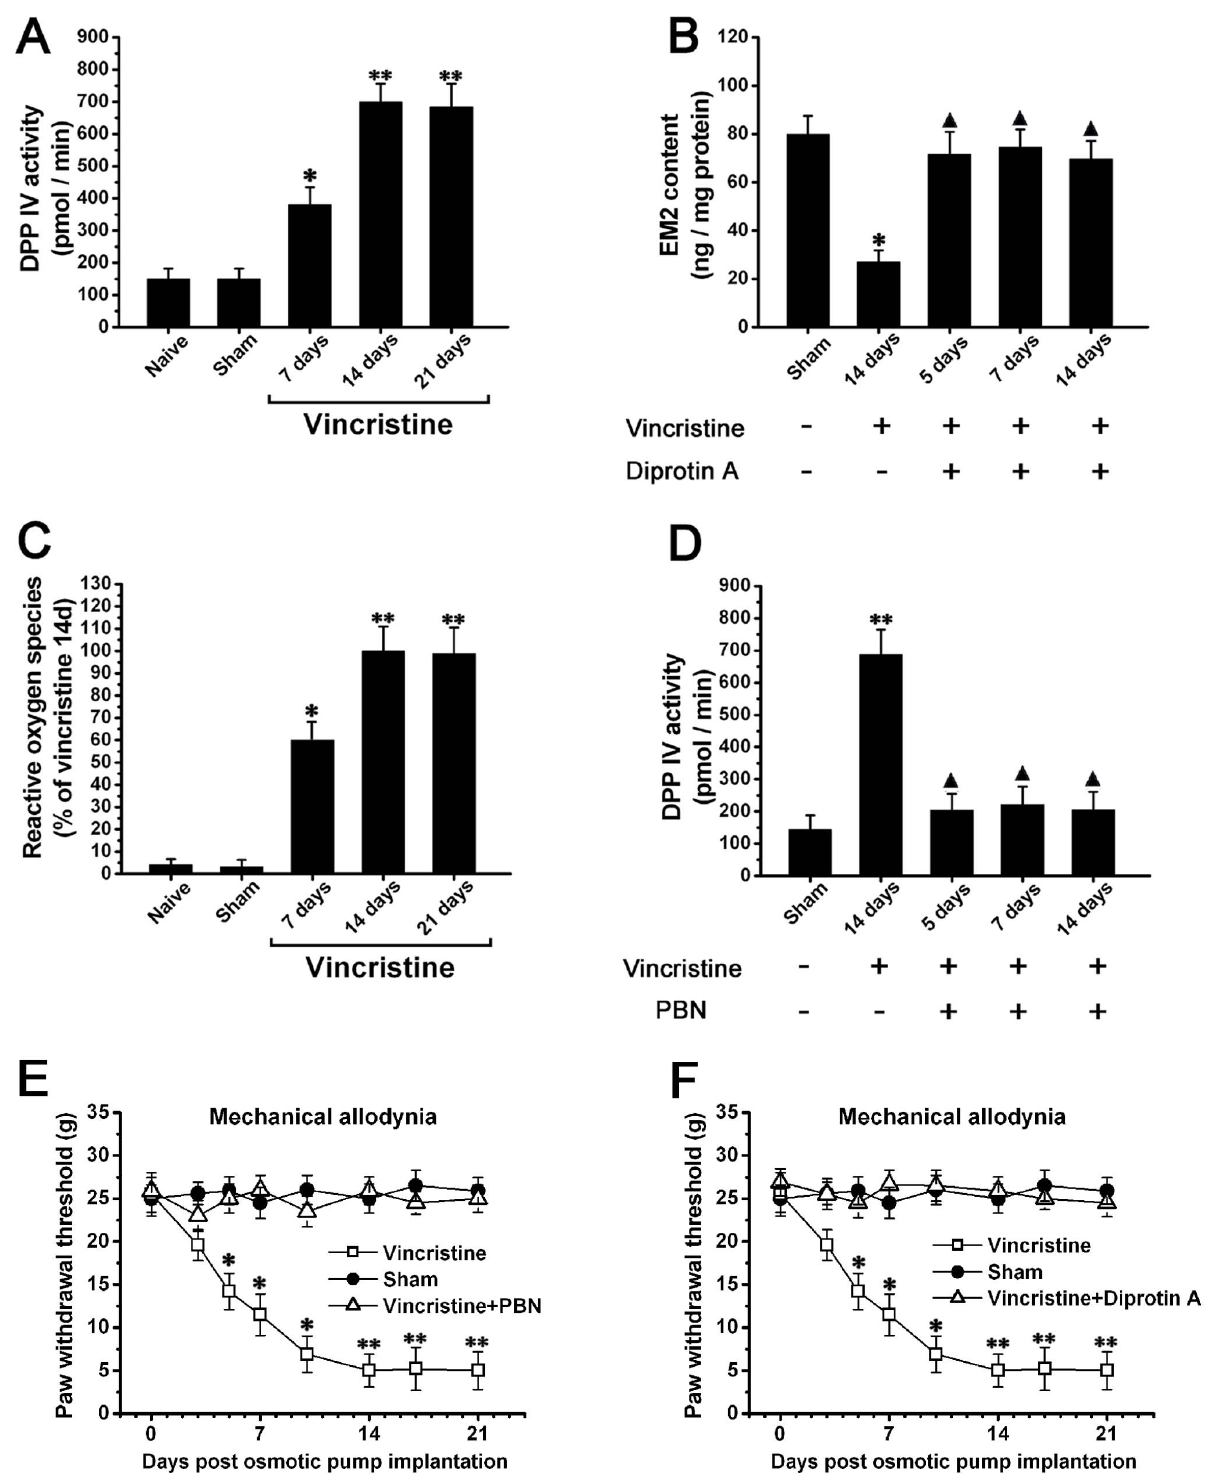
Figure 6. Spinal decreased EM2 was induced by oxidative stress mediated increased activity of dipeptidylpeptidase IV (DPP IV). (A) Compared to Naive group and Sham group, the activity of spinal DPP IV was significantly increased in Vincristine group. (B) A systemic treatment with diprotin A (inhibitor of DPP IV) blocked the decrement of spinal EM2 in Vincristine group. (C) Compared to Naive group and Sham group, the spinal reactive oxygen species was significantly increased in Vincristine group. (D) A systemic treatment with PBN (a scavenger for reactive oxygen species) significantly attenuated the increased activity of DPP IV in Vincristine group. (E) The treatment with PBN prevented the forming of mechanical allodynia in Vincristine group. (F) The treatment with diprotin A prevented the forming of mechanical allodynia in Vincristine group rats. *P , 0.05, **P , 0.01 vs. Naive group and Sham group; m P , 0.05 vs. Vincristine group at 14 days.